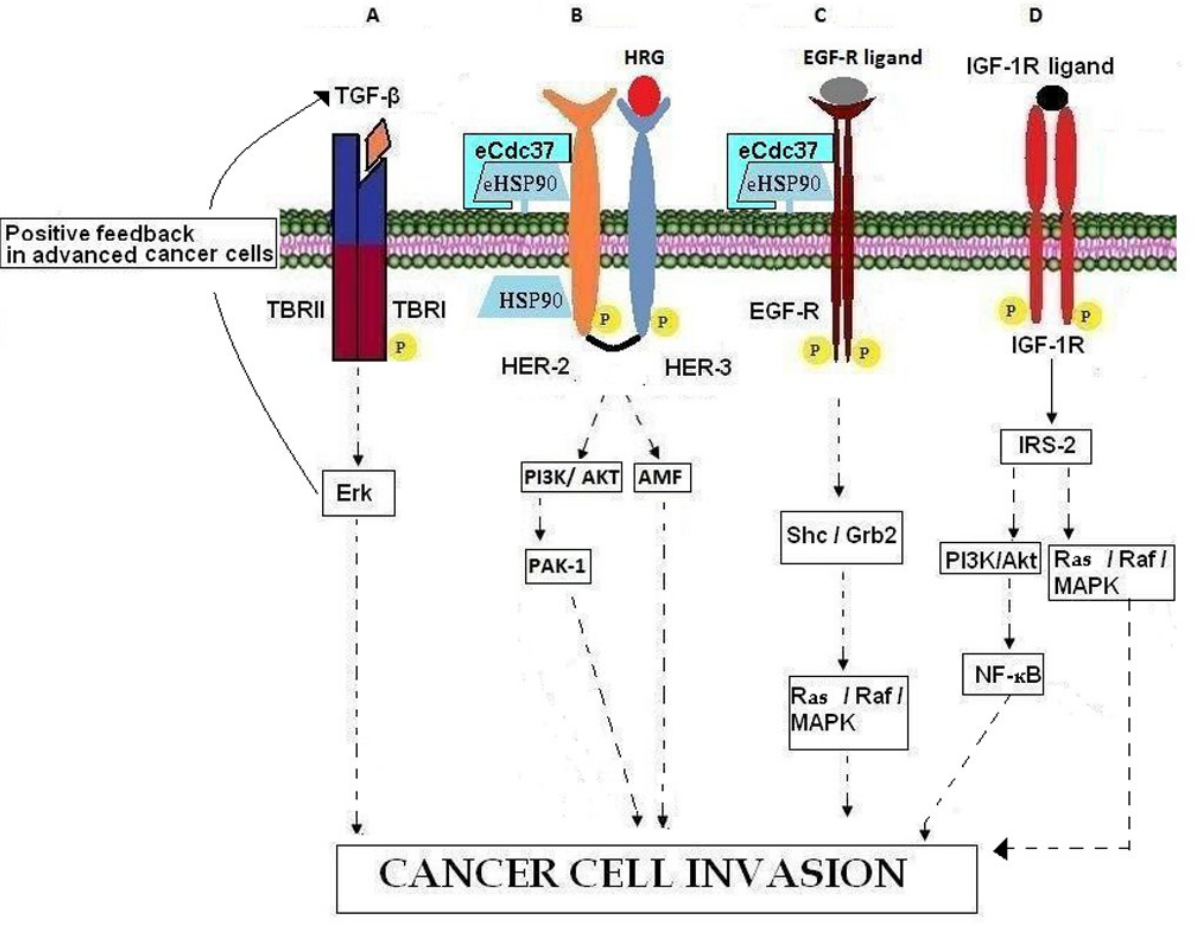
Figure 2. Involvement of growth factors, growth factor receptors, and chaperones in cancer cell invasion. ( A ) In advanced cancer cells, TBRII activation promotes cancer cell invasion by binding over-expressed TGF-β and activating Erk which induces a positive feedback loop by further increasing TGF-β. ( B ) HRG binding to HER-3 leads to the formation of HER-3/HER-2 heterodimers, the activation of downstream kinase signaling pathways and in actin re-arrangement and cell invasion. HSP90 contributes to intracellular HER-2 stabilization while eHSP90- eCdc37-HER-2 heterocomplexes are necessary for HER-2 heterodimerization with HER-3, leading to cell invasion through PI3K/AKT and AMF signaling pathways. ( C ) EGFR binding to its ligands leads to activation of the Ras/Raf//MAPK pathways resulting in cancer cell invasion. The chaperoning activity of eHSP90, associated with co-chaperone eCdc37, is necessary for EGFR stabilization. ( D ) Binding of IGF-1R with its ligand results in IGF-1R auto-phosphorylation, recruitment of adaptor proteins such as IRS-2 and subsequent activation of PI3K/AKT and Ras/Raf/MAPK pathways which promote the invasion